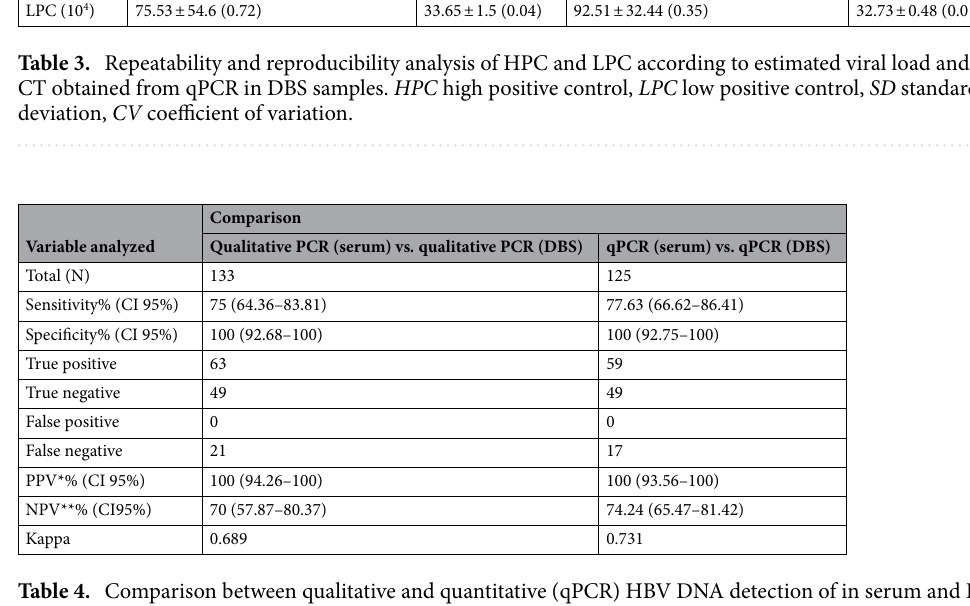
Table 4. Comparison between qualitative and quantitative (qPCR) HBV DNA detection of in serum and DBS samples. CI confidence interval. *Predictive positive value; **Predictive negative value.